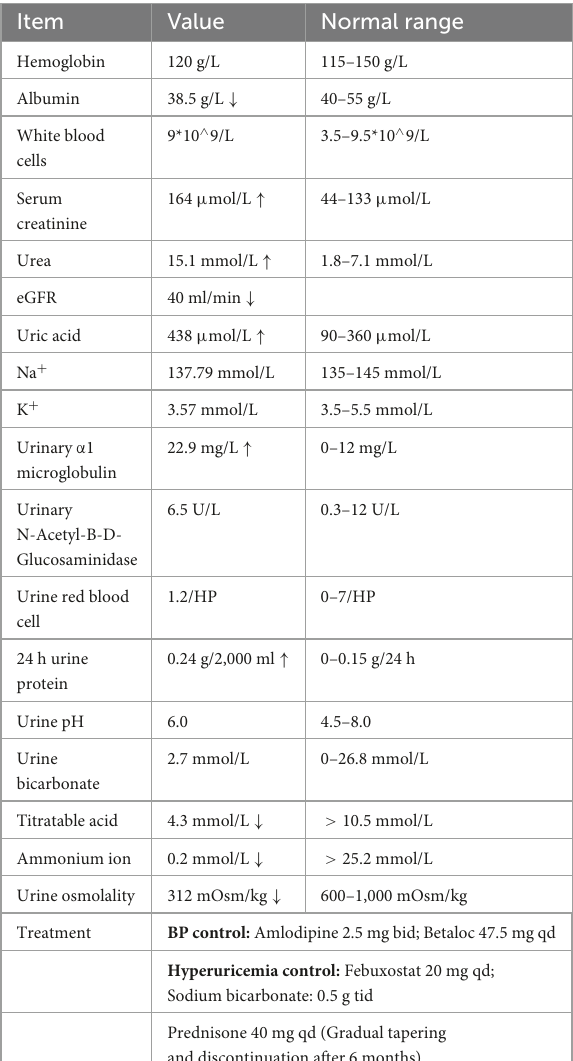
TABLE 1 Clinical information and treatment of the